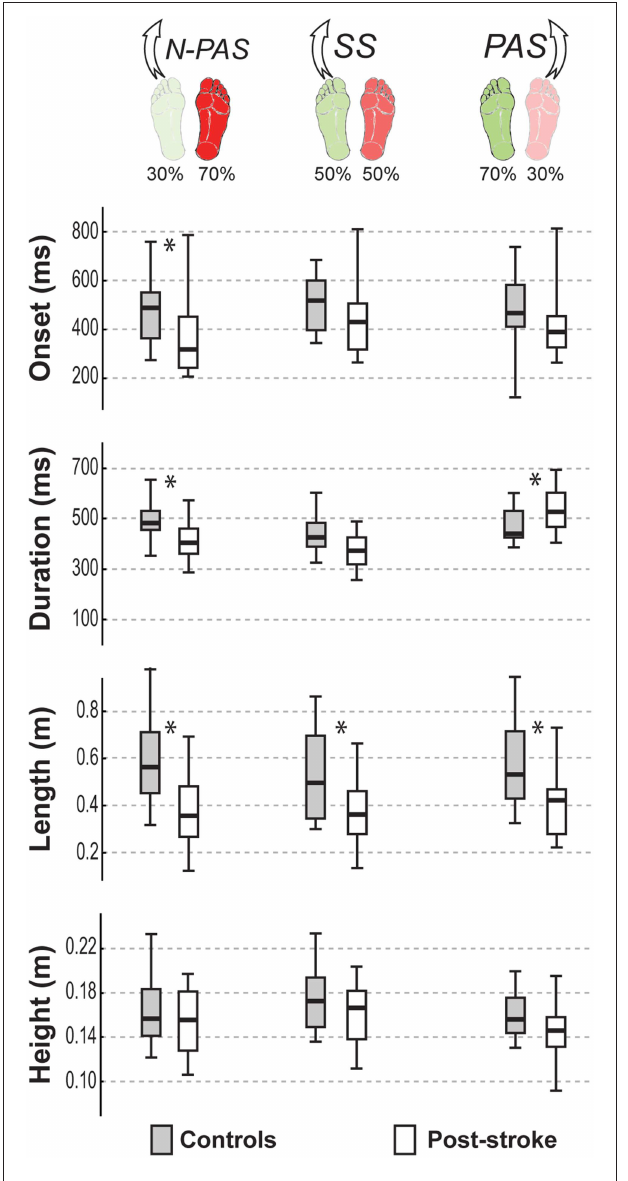
FIGURE 5 | Step characteristics by group. The median (thick line) of the step characteristics is presented for each group and each condition in which they were compared. Boxes represent 25 and 75th percentile. Bars represent min and max values. *Indicates a difference between groups at p < 0.05.